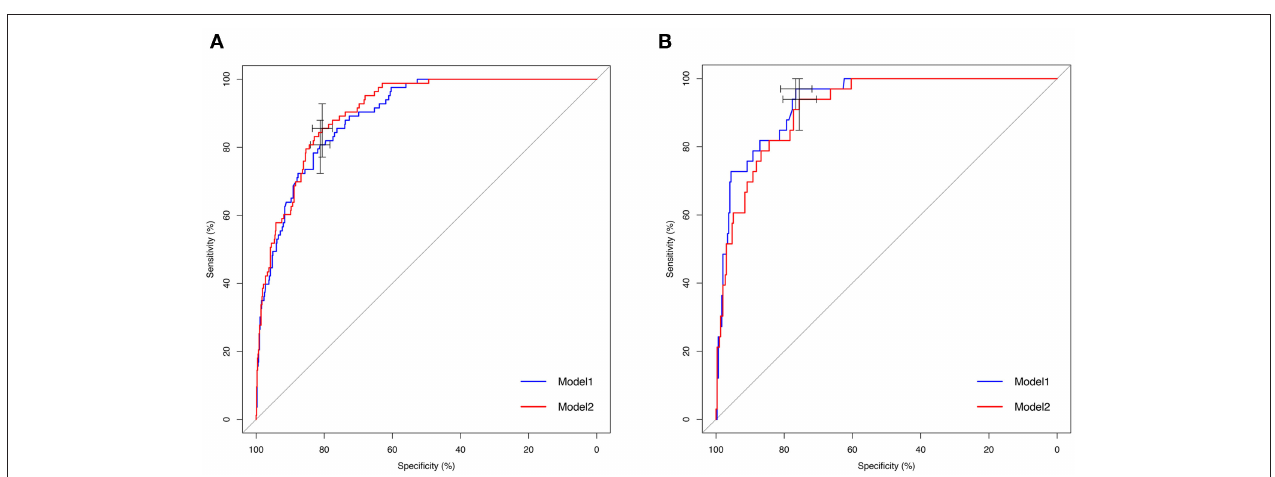
FIGURE 3 | Receiver operating characteristic (ROC) curves of Model1 and Model2 for predicting lymph node metastasis in the training and validation cohorts. (A) ROC curve in the training cohort. Area under ROC curve (AUC): 0.895 (95%CI: 0.866–0.925; sensitivity: 80.7%, specificity: 81.2%) in Model 1 vs. 0.907 (95%CI: 0.880–0.934; sensitivity: 85.5%, specificity: 80.6%) in Model2 ( P = 0.171). (B) ROC curve in the validation cohort. AUC: 0.931 (95%CI: 0.896–0.967; sensitivity: 97.0%, specificity: 76.6%) in Model1 vs. 0.915 (95%CI: 0.875–0.955; sensitivity: 93.9%, specificity: 75.6%) in Model2 ( P = 0.047).